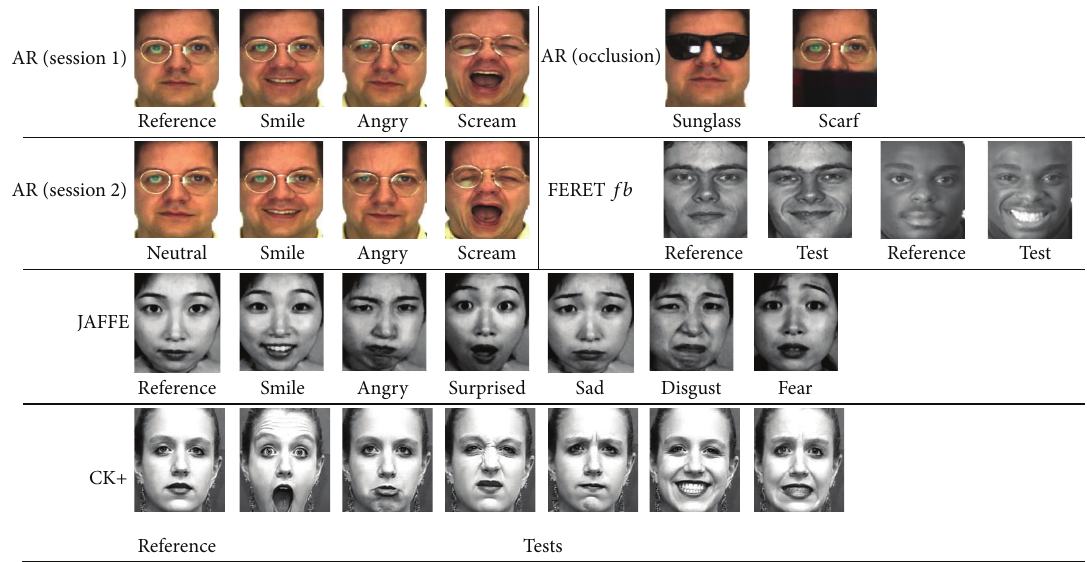
Figure 9: Examples of images used in this paper. The variations of probe samples in AR are neutral, smile, angry, scream, sunglass, and scarf, while the variations of probe samples in JAFFE are neutral, smile, angry, surprised, sad, disgust, and fear. FERET probe samples’ variations, however, consist of mixtures of several different expressions while CK+ consists of several FACS-coded expressions.